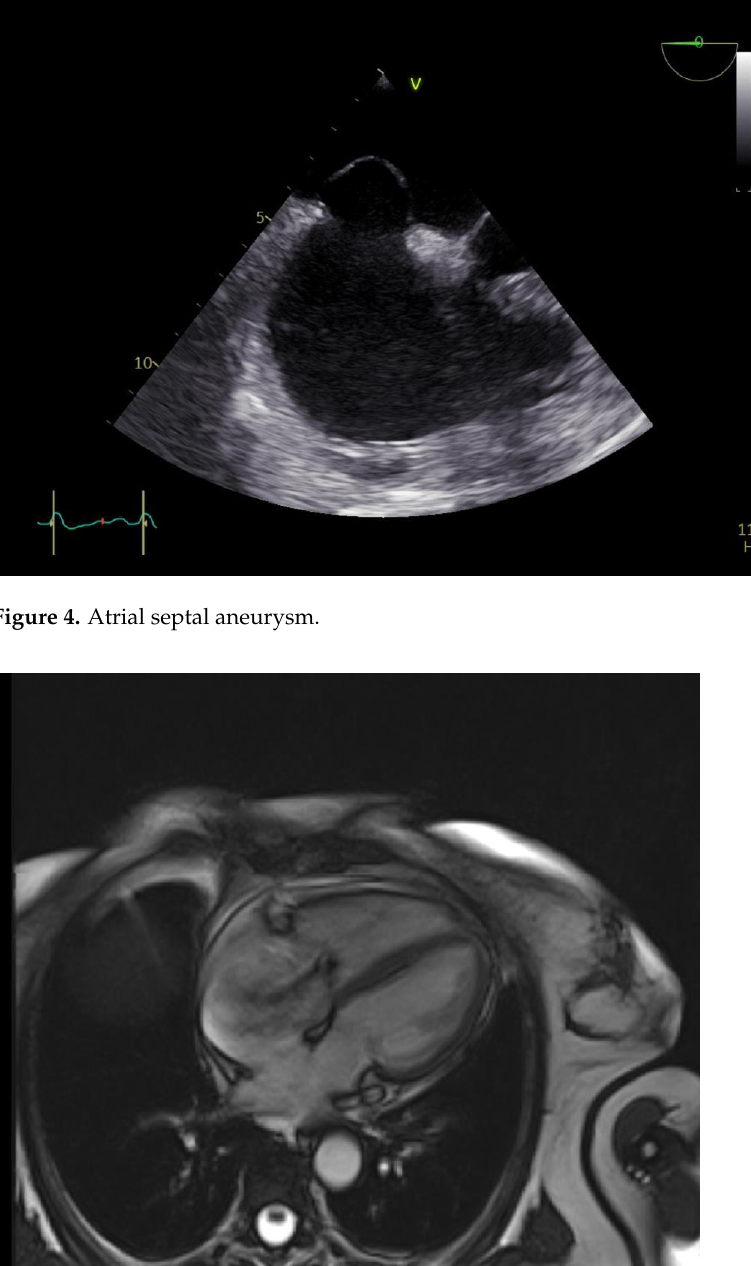
Figure 3. Moderate pulmonary regurgitation.